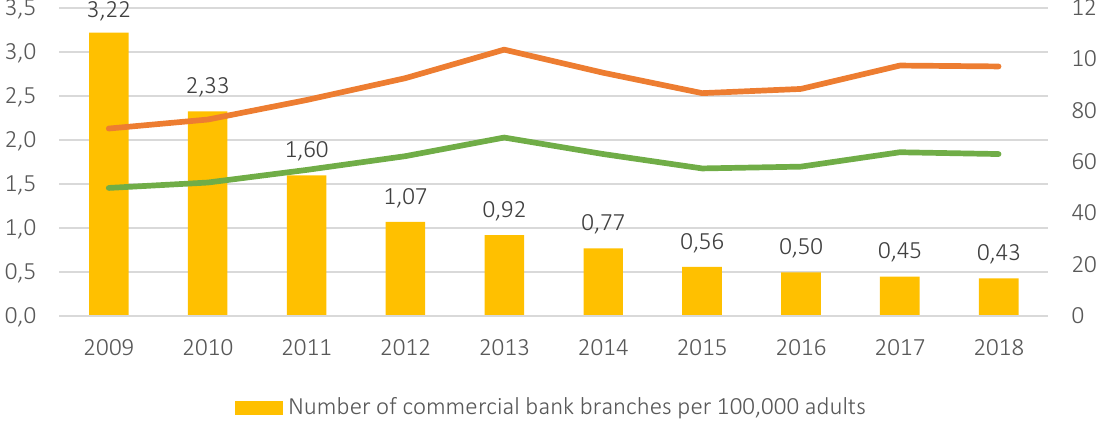
Table 2. Number of commercial bank branches per 100,000 adults in selected countries in 2009–2018